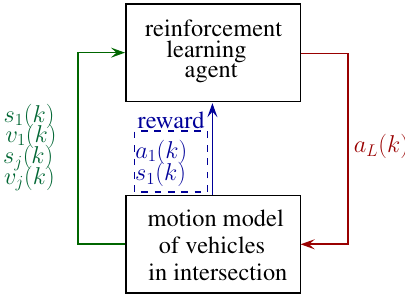
Figure 4. Control structure in the learning